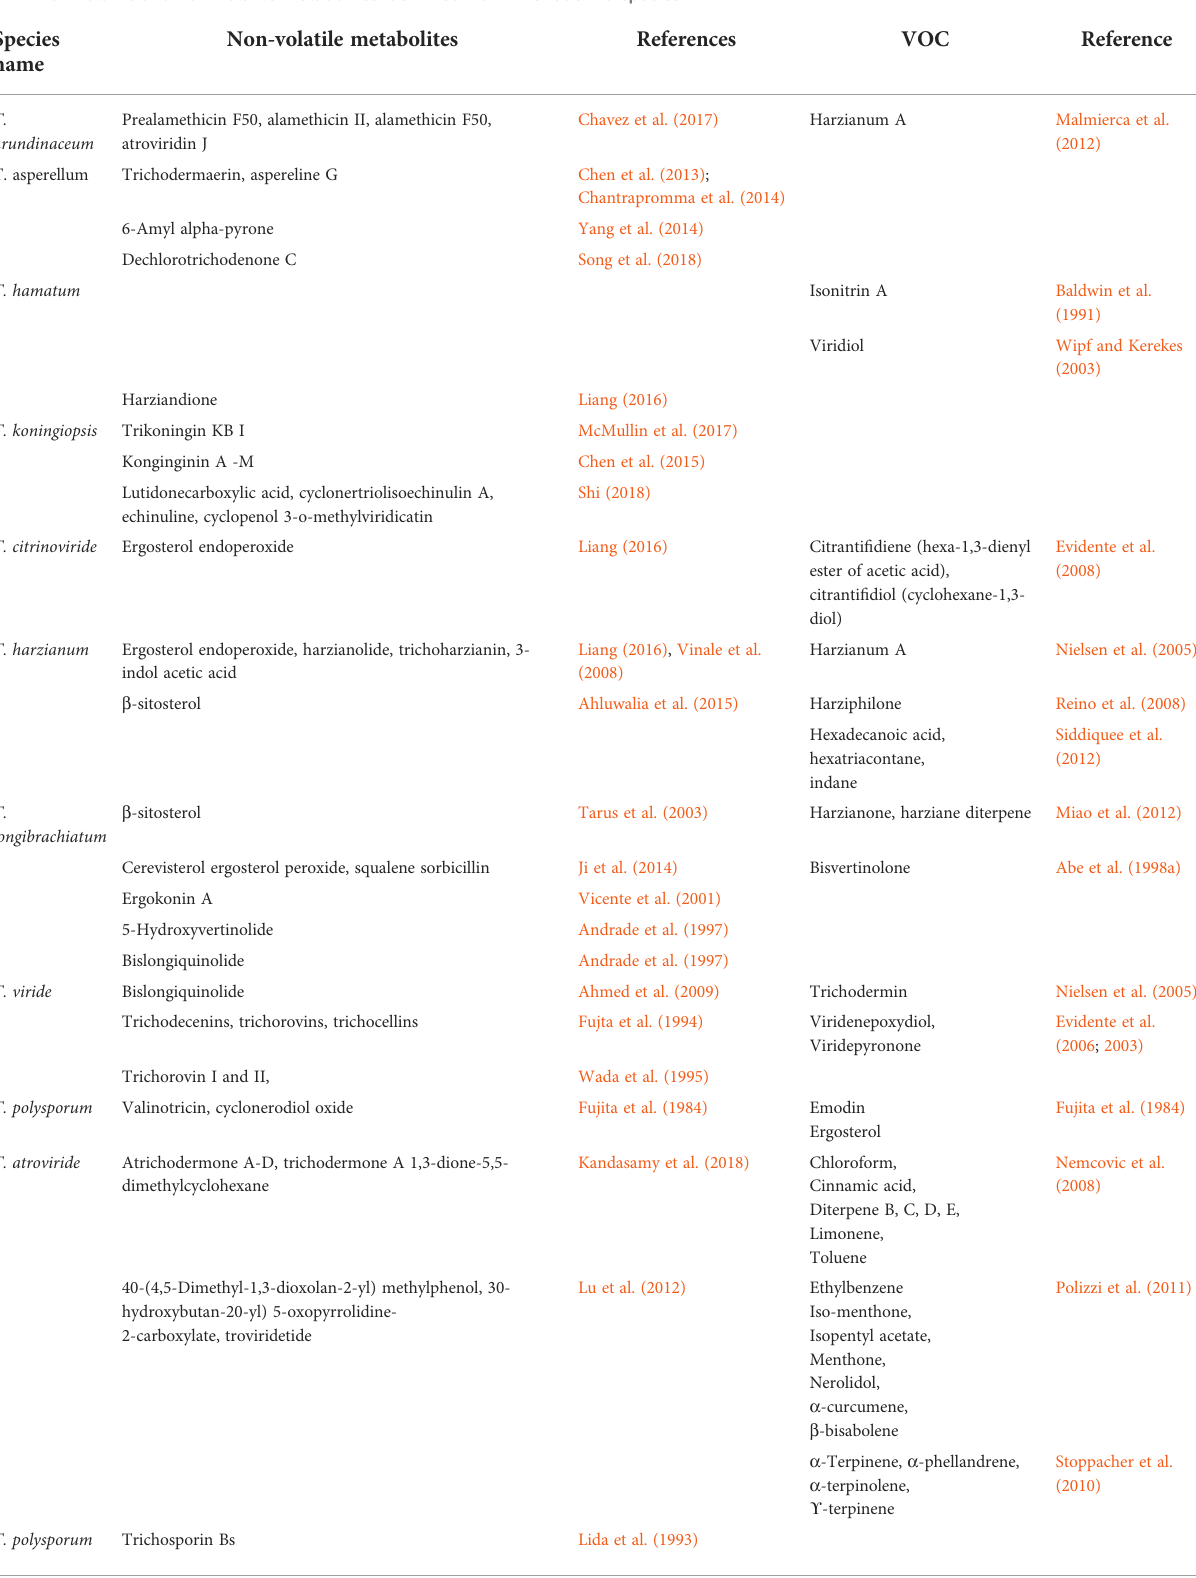
TABLE 3 Volatile and non-volatile metabolites identi fi ed from Trichoderma